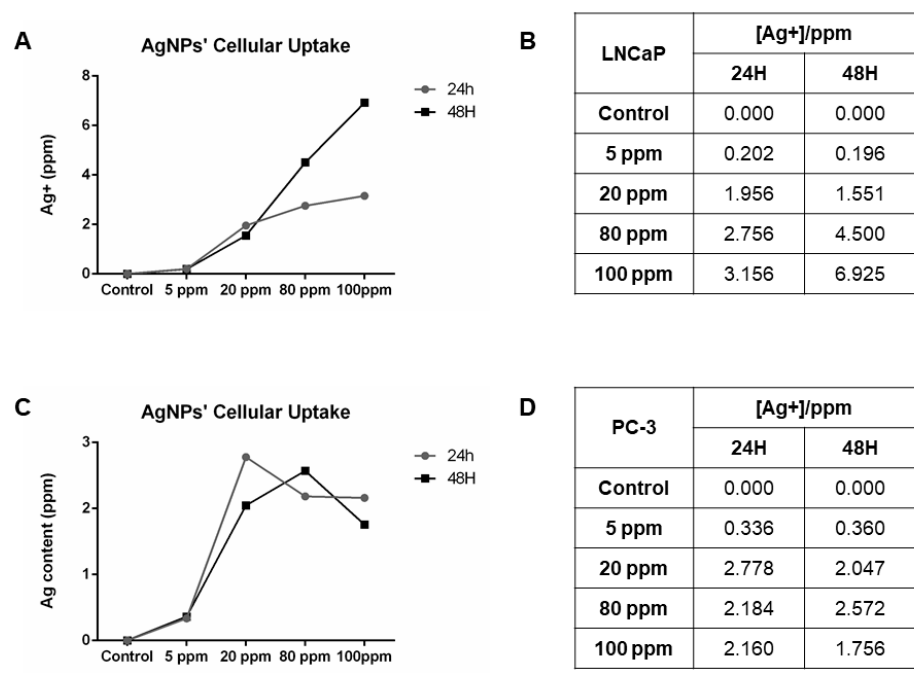
Figure 14. AgNPs’ cellular uptake quantification through Ag + quantification by atomic absorption spectrometry (AAS) in LNCaP cells ( A , B ) and in PC-3 cells ( C , D ).